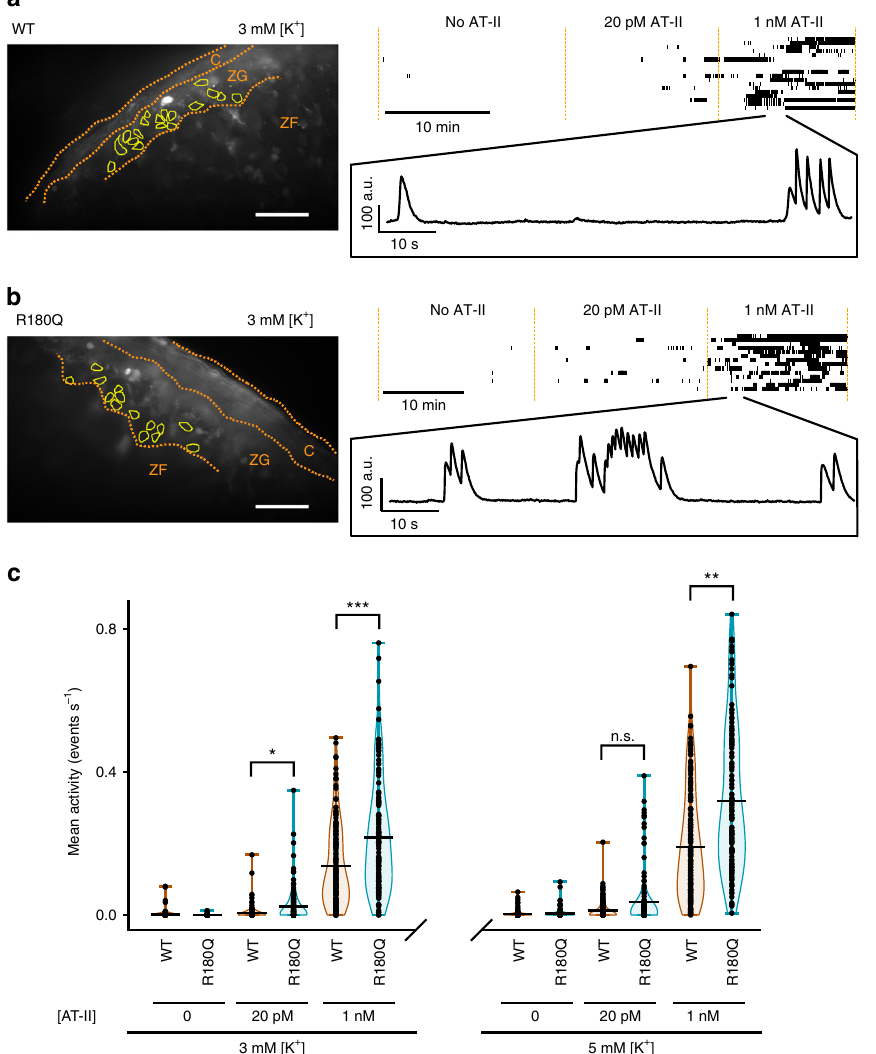
Fig. 8 Clcn2 R180Q/ + mice have altered glomerulosa calcium signaling. a, b Left, representative average projection of 10 frames (1 s) without AT-II of a recording of calcium signals from acute adrenal slice preparations of either ( a ) wildtype (WT) or ( b ) Clcn2 R180Q/ + mice (R180Q). Scale bar: 50 µ m. Borders of the capsule (C), zona glomerulosa (ZG) and the outer part of the zona fasciculata (ZF) are shown in orange. Bright white spots likely correspond to apoptotic cells. Cells (yellow outlines) were selected from the recording, and mean intensity values over time were extracted. Top right, activity of all selected cells is shown in a burst plot. Cells are separated in rows along the y-axis, with time displayed along the x -axis. Detected spikes of the calcium signal are plotted as vertical lines with multiple spikes in close proximity merging into longer bars. Extracellular solution was perfused continuously and changed at the time points indicated. Representative examples of variations in the fl uorescence recorded at 1 nM of AT-II are shown in a magni fi ed inset. ( c ) Violin plots of cellular activity (WT in orange, Clcn2 R180Q/ + in blue) in the zona glomerulosa as determined by the number of spikes per cell and second. All data points are shown, a black horizontal bar denotes the mean of the distribution. ( N (cells): 3 mM [K + ], no AT-II – WT: N = 126, Clcn2 R180Q/ + N = 134, not tested; 3 mM [K + ], 20 pM AT-II - WT: N = 134, Clcn2 R180Q/ + N = 134, χ 2 (1) = 5.3413, P = 0.0208 (*); 3 mM [K + ], 1 nM AT – II - N = 157, Clcn2 R180Q/ + N = 134; χ 2 (1) = 11.97, P = 0.0005 (***); 5 mM [K + ], no AT-II – WT: N = 150, Clcn2 R180Q/ + N = 134, not tested; 5 mM [K + ], 20 pM AT-II - WT: N = 153, Clcn2 R180Q/ + N = 134, χ 2 (1) = 3.2957, P = 0.0695 (n.s.); 5 mM [K + ], 1 nM AT – II - N = 154, Clcn2 R180Q/ + N = 134, χ 2 (1) = 8.3487, P = 0.0039 (**); likelihood ratio